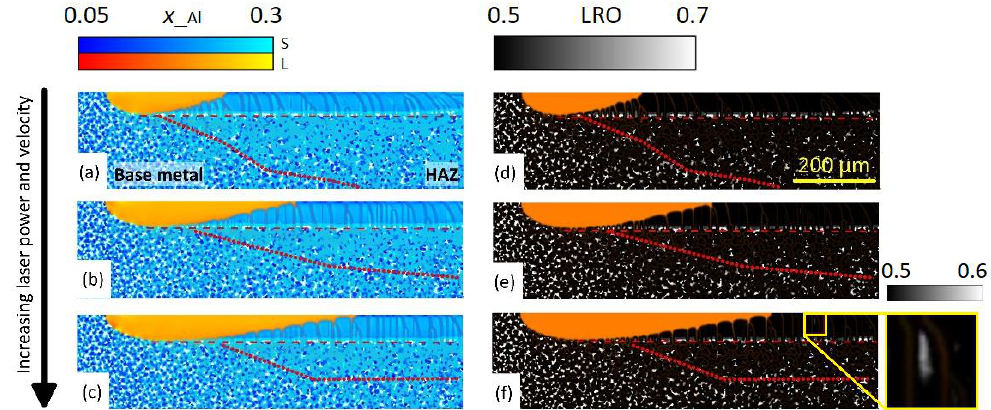
Figure 8. Simulated concentration distribution (left column) and long-range order parameter (right column) in laser processing of Ni-0.2Al alloy. The white points in the right column indicate ordered phases. Dotted lines indicate the approximate boundary of the HAZ (phase). Dashed lines show the boundaries between the re-solidified zone and the HAZ. The inset in ( f ) indicates an ordered phase in the re-solidified zone. ( a , d ) p = 15 GW/m 2 , v scan = 0.5 m/s; ( b , e ) p = 21 GW/m 2 , v scan = 0.7 m/s ( c , f ); p = 27 GW/m 2 , v scan = 0.9 m/s.